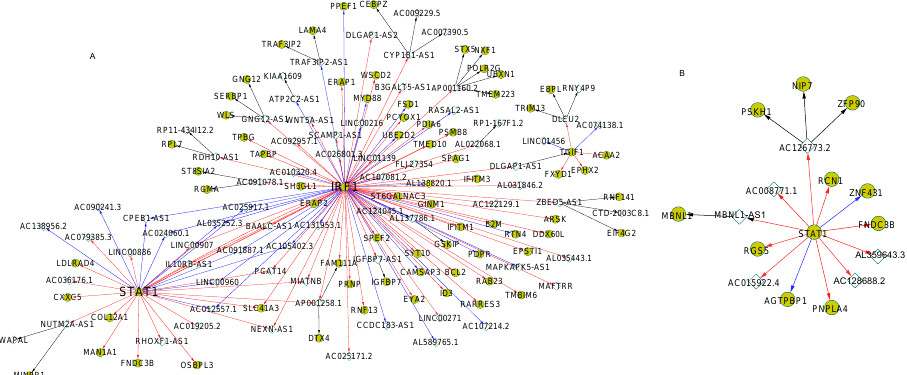
Figure 4. The regulatory cascades with transcription factor STAT1 as the root in the neuron cells. The expression correlation coefficients of connected genes were larger than 0.8 in the cascades. ( A ) showed the regulatory cascade in the normal samples. ( B ) represented the cascade with the root gene STAT1 in the ASD samples. The gold circles denoted PCGs and the white diamonds represent lncRNAs. The directed arrows indicate the regulations from the regulators to the target genes with diverse correlation patterns: Positive (red), negative (blue) and lncRNA-target based on enhancer matching (black).